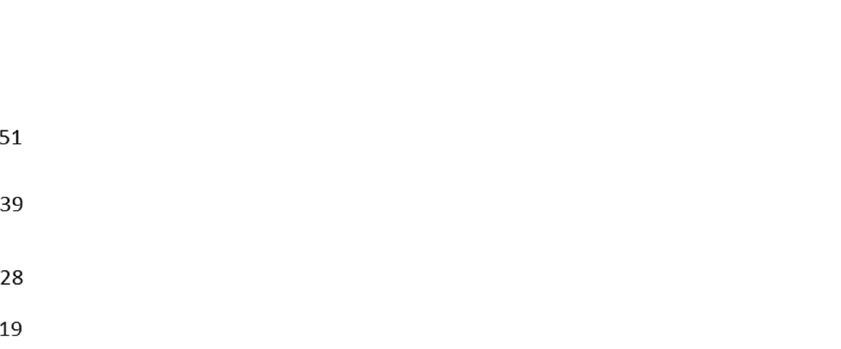
Figure A2. Western blot analyses demonstrating specificity of p53 specific antibody. Data are shown for H1299 p53 − / − cells transfected with 1 µ g of pcDNA3 plasmid expressing p53 β , p53 α , or pCDNA3 (empty vector). Cells were harvested 24 h after transfection. The protein extract (5 μ g) was analyzed by Western blot using a p53 β antibody raised in sheep against peptide TLQDQTSFQKENC conjugated to KLH protein. After three injections of the p53 β specific peptide/KLH conjugate, serum was harvested and the p53 β antibody purified by chromatography on peptide a TLQDQTSFQKENC-Sepharose bead column as previously described [19].